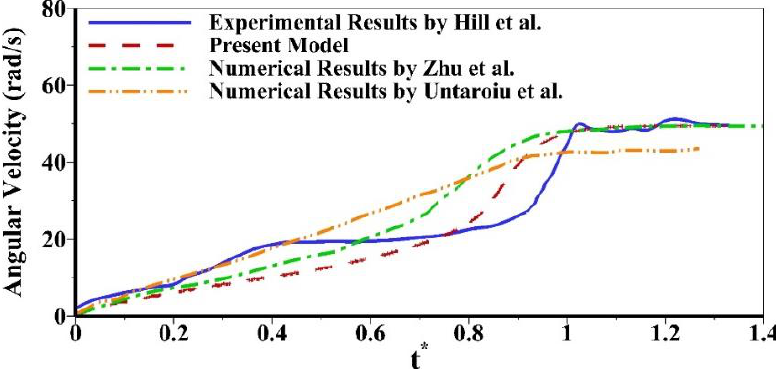
Figure 2. Comparison of variations in angular velocities for the Darrieus wind turbine.